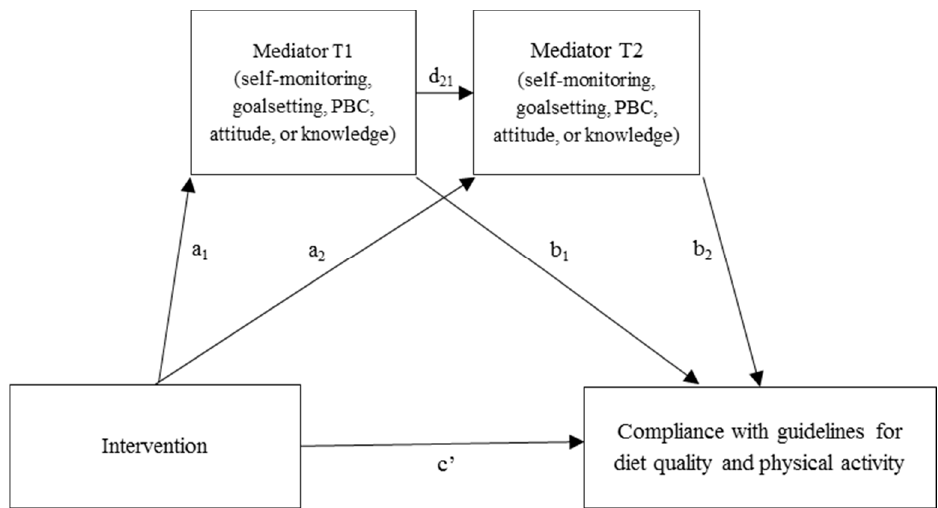
Figure 1. Hypothesised mediation pathways in the PhysioDom Home Dietary Intake Monitoring (HDIM) intervention. One model for each outcome and mediator.